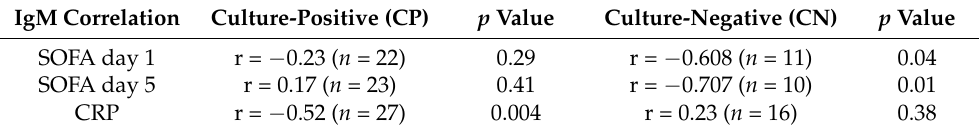
Table 3. Spearman non-parametric correlation (r) of IgM levels with SOFA scores and plasma biomarkers in culture-positive and negative sepsis